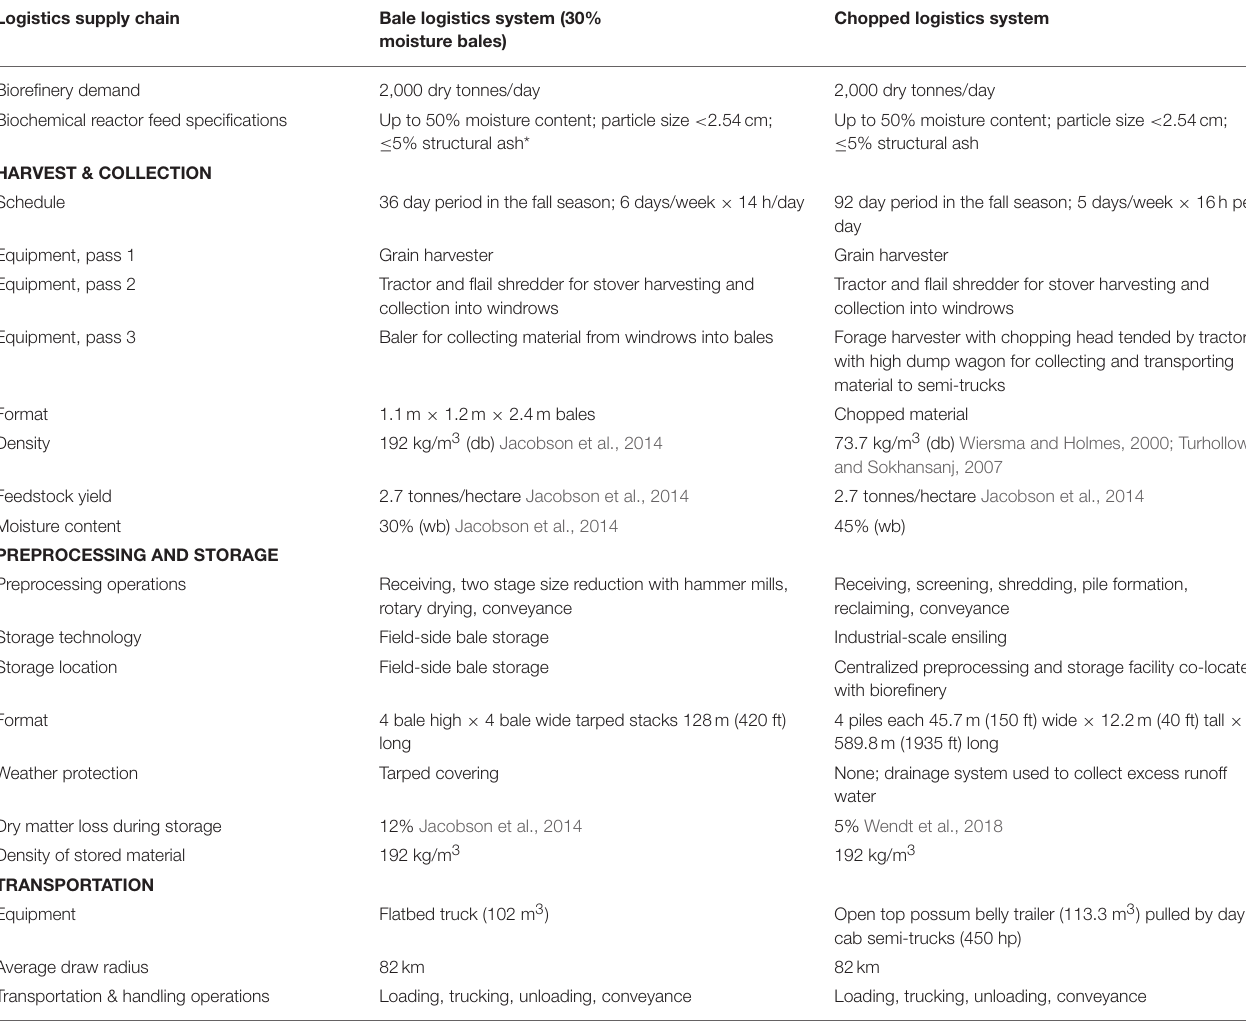
TABLE 2 | Comparison of dry and wet feedstock supply logistics